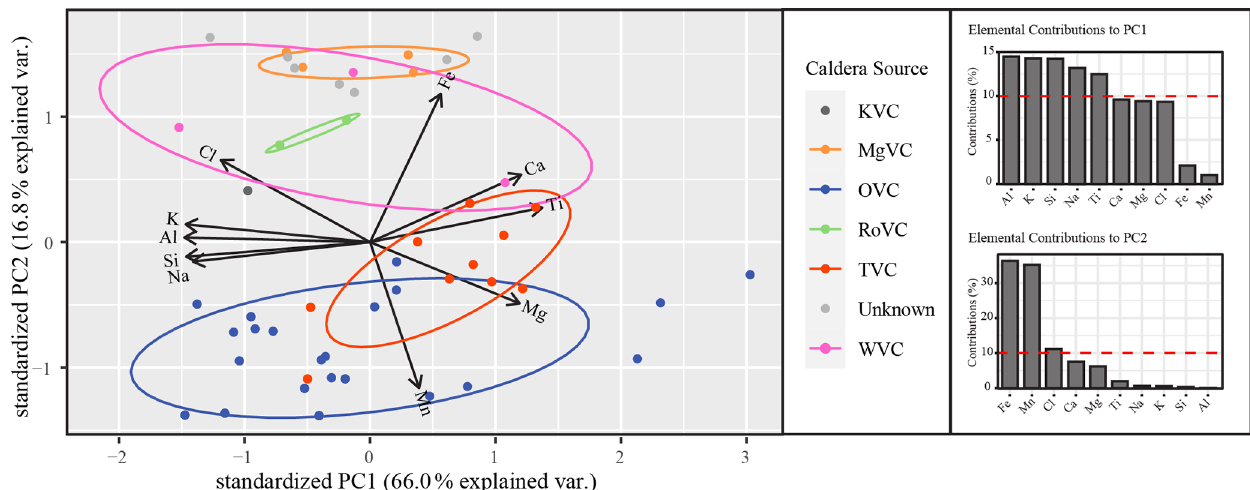
Figure 9. Results of PCA analysis on all TephraNZ major-element reference data for glass (normalised). Data are scaled to allow comparison within the PCA analysis. Tephra samples are coloured as per their source centre, and ellipses highlight the mean compositional region for each source caldera (KVC – Kapenga Volcanic Centre, MgVC – Mangakino Volcanic Centre, OVC – Okataina Volcanic Centre, RoVC – Rotorua Volcanic Centre, TVC – Taup¯o Volcanic Centre, and WVC – Whakamaru Volcanic Centre). PCA analysis was performed in R (see Supplement 1 for R script). Bar plots highlight the top elemental contributions for PC1 and PC2. The red dashed lines on the elemental contribution plots indicate the expected average contribution; if the contribution by each element were uniform, the expected value would be 1/no. of variables (e.g. 1 / 9 =∼ 11%). Therefore, a variable with a contribution larger than this cut-off line ( ∼ 11%) is considered important in contributing to the